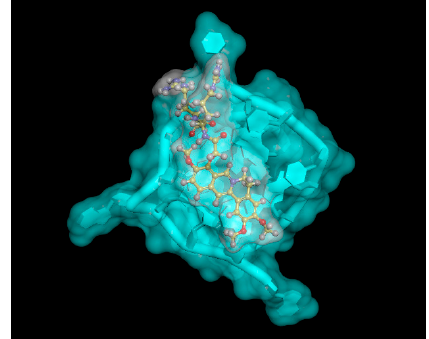
Figure 2. Interaction between DNA G-Quadruplex (C-Kit1) and 4a . Blue = DNA; yellow = Carbon; dark blue = Nitrogen, red = Oxygen.